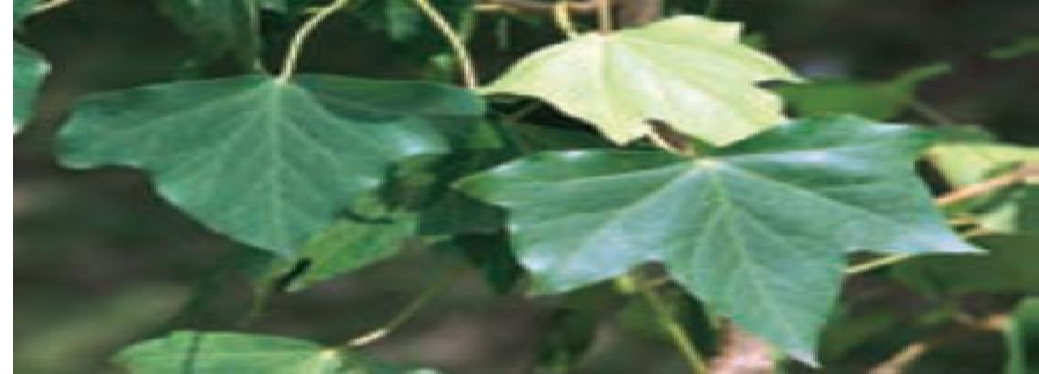
Figure 1: Photo of H. helix L. (6)